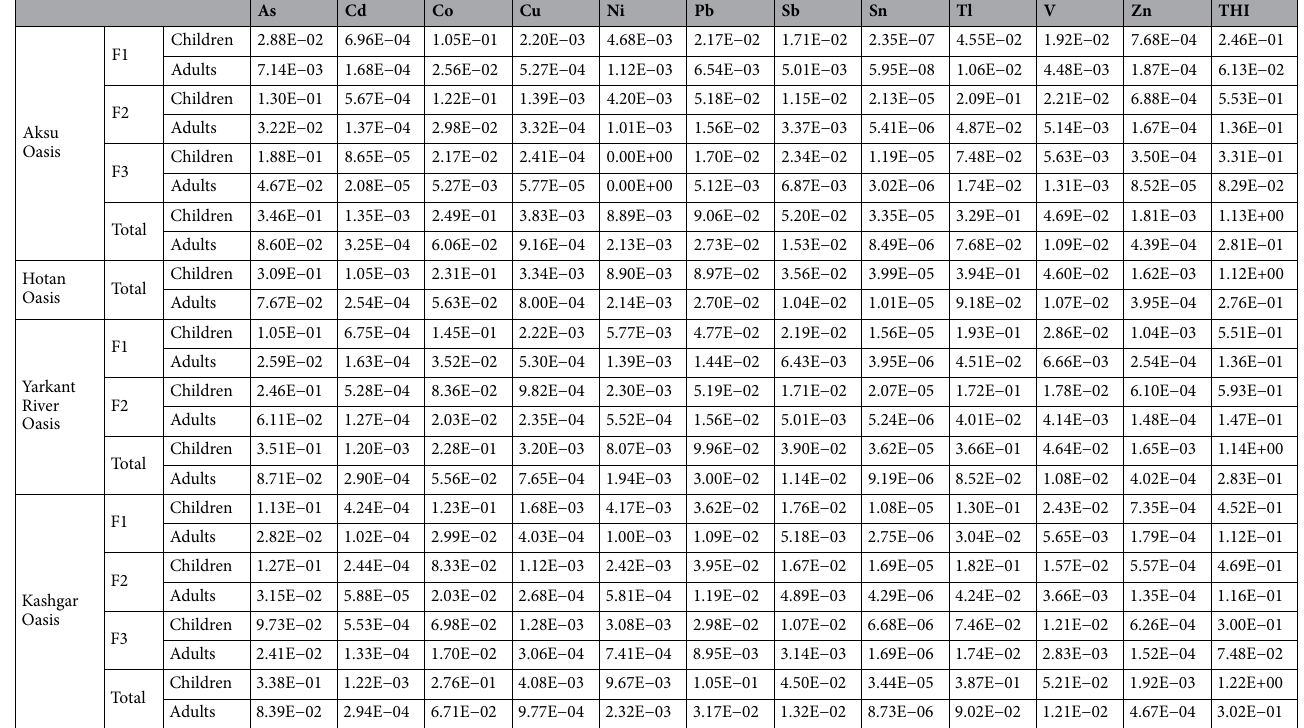
Table 4. Specific noncarcinogenic risks of PTEs from different sources.